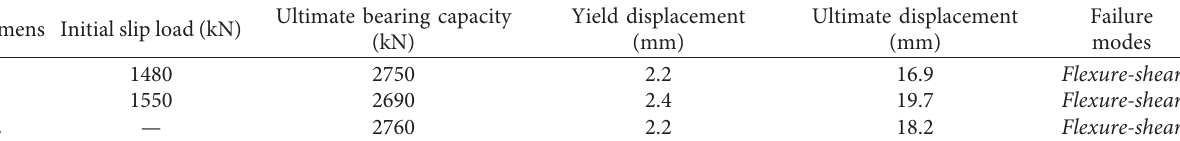
Table 5: Bearing capacity and failure modes of models.